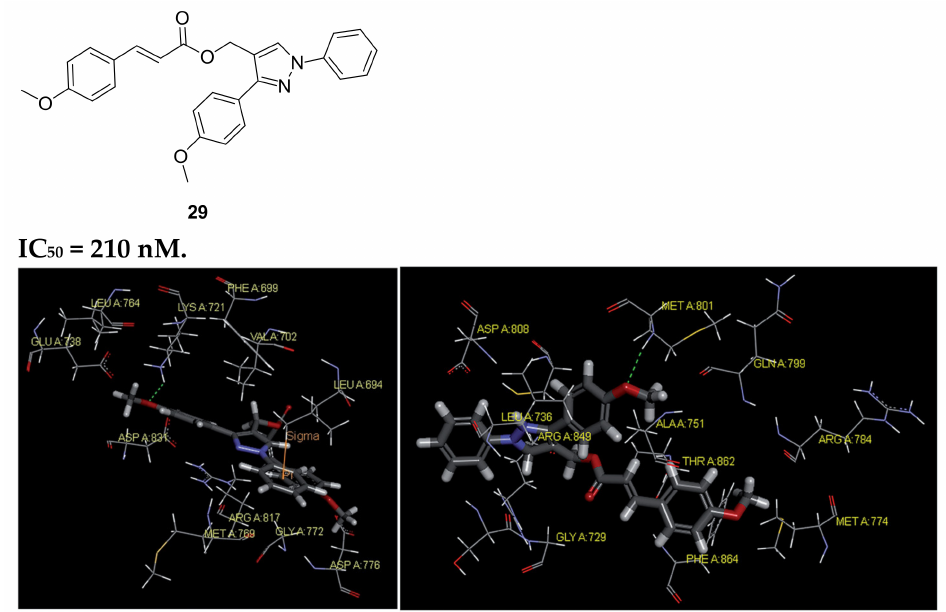
Figure 31. The structure of compound 29 and its IC50 value( up ). Structure and molecular dock- ing of compound 29 into EGFR ( left ) and HER2 ( right ). The dotted lines = hydrogen bond; yellow line = pi-sigma interactions [41].